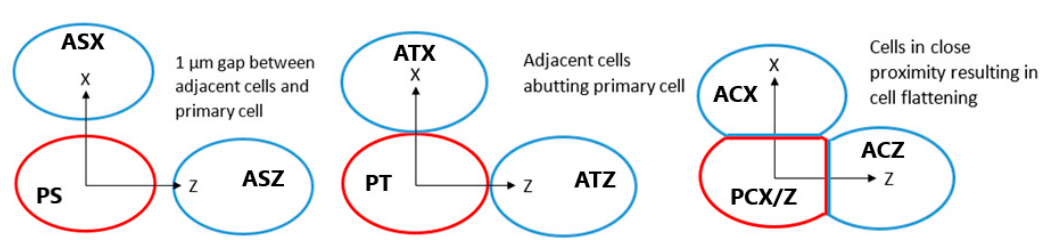
Figure 9. Diagram showing positions of adjacent cells in blue relative to the primary cell containing GNPs in red for separated, touching and compressed cells. Each cell is assigned a label, for the first letter P indicates the primary cell and A indicates the adjacent cell, for the second letter C denotes compressed cells, T denotes touching cells and S indicates separated cells, for the third letter X and Z indicate cells separated along the X and Z axes respectively. Not to scale.